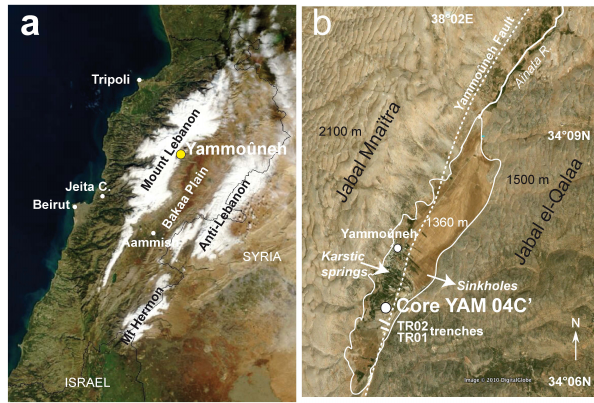
Fig. 3. The Yammoˆuneh basin in Lebanon. (a) Satellite view of Lebanon in winter (January 2003), main morphological structures. (b) The Yammoˆuneh basin with location of the sedimentary pro- files. Dashed line: surface trace of the Yammo ˆ uneh Fault. Arrows schematize the groundwater circulation, from the Mna¨ıtra Plateau which provides the main water inflow to the basin via karstic springs emerging along the western edge of the basin, and infiltration along the eastern